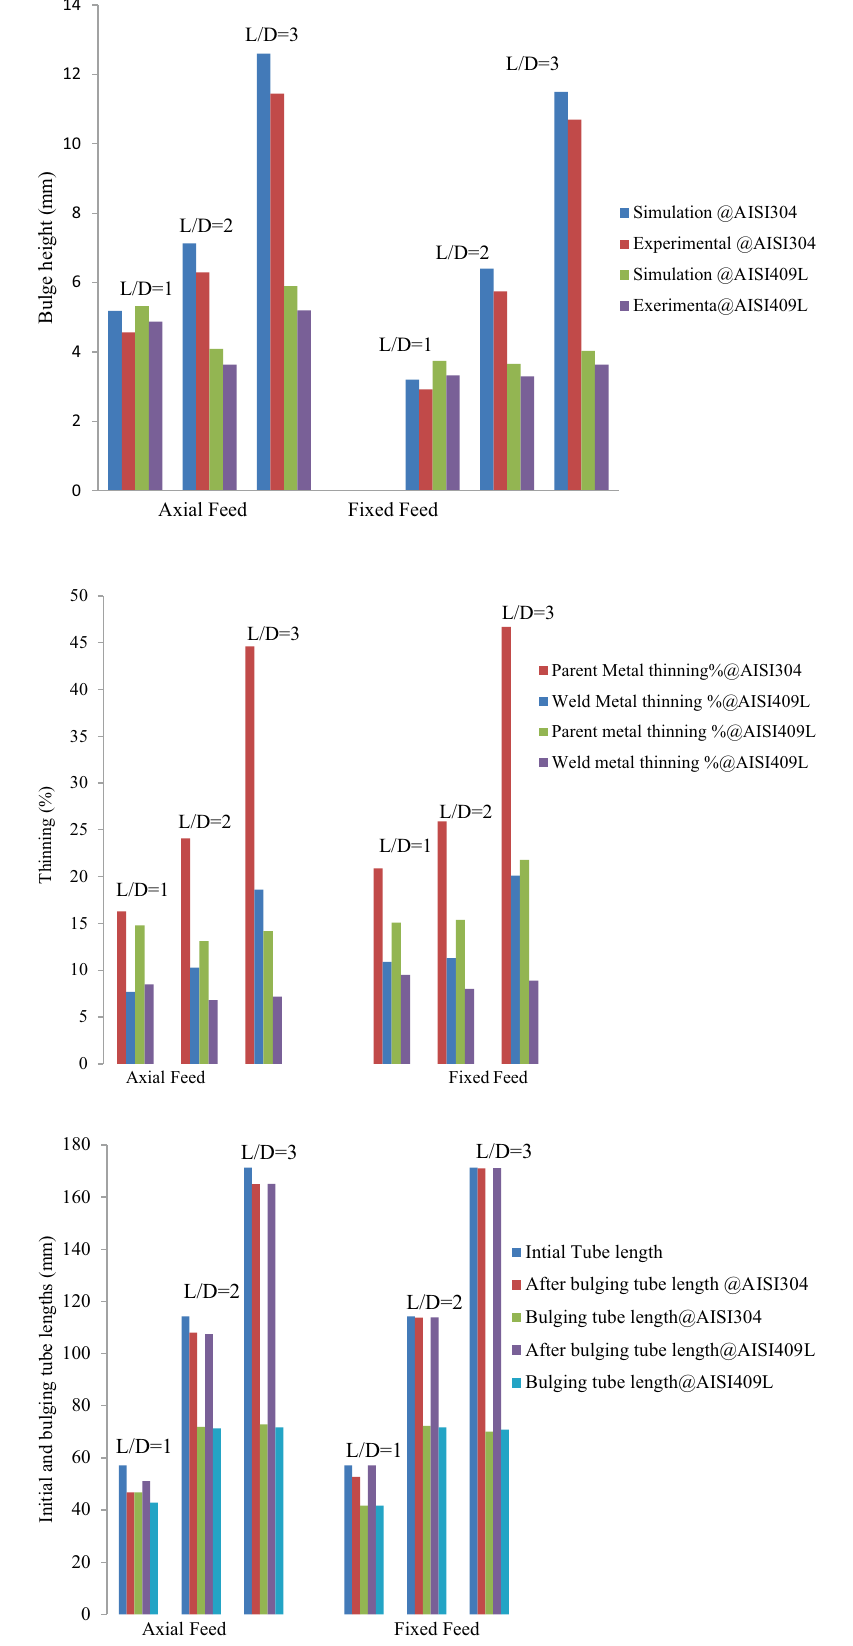
Fig. 13 Variation of bulge height with axial and fixed feed